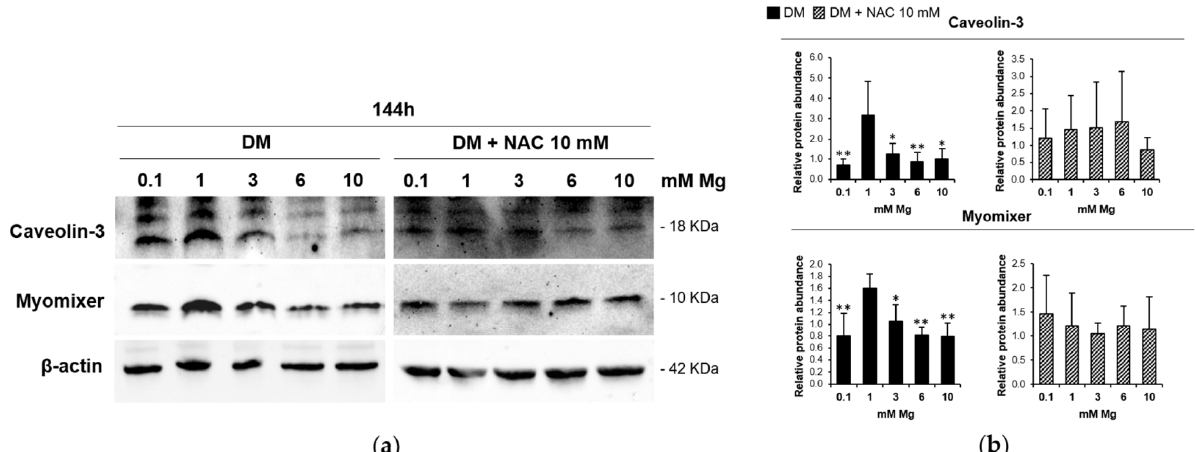
Figure 4. Low and high Mg inhibit myoblast fusion. C2C12 cells were treated or not for 24 h with NAC in CM and then cultured in DM for 144 h with different extracellular concentrations of Mg. Caveolin-3 and Myomixer expression was analysed by Western blot. β -actin was used as control of loading. A representative blot ( a ) and densitometry obtained by ImageLab ( b ) are shown. * Indicates significance with respect to 1 mM Mg (* p ≤ 0.05; ** p ≤